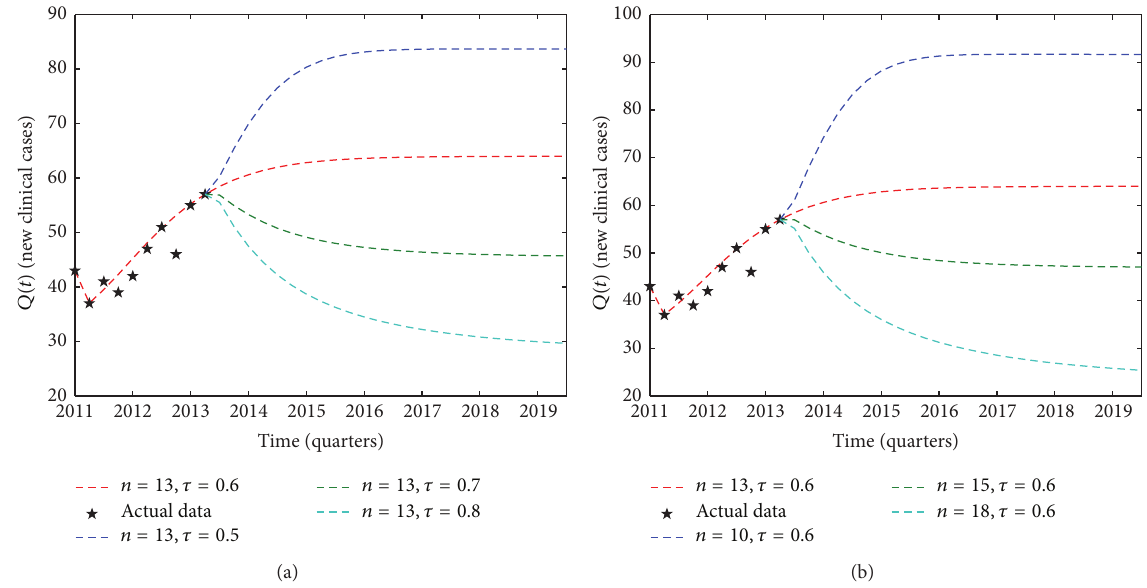
Figure 4: The variations of new clinical cases of system (1) for different values of 𝑛 and 𝜏 since the second quarter of 2013. (a) New clinical cases with different values of 𝜏 with system (1). (b) New clinical cases with different values of 𝑛 with system (1).